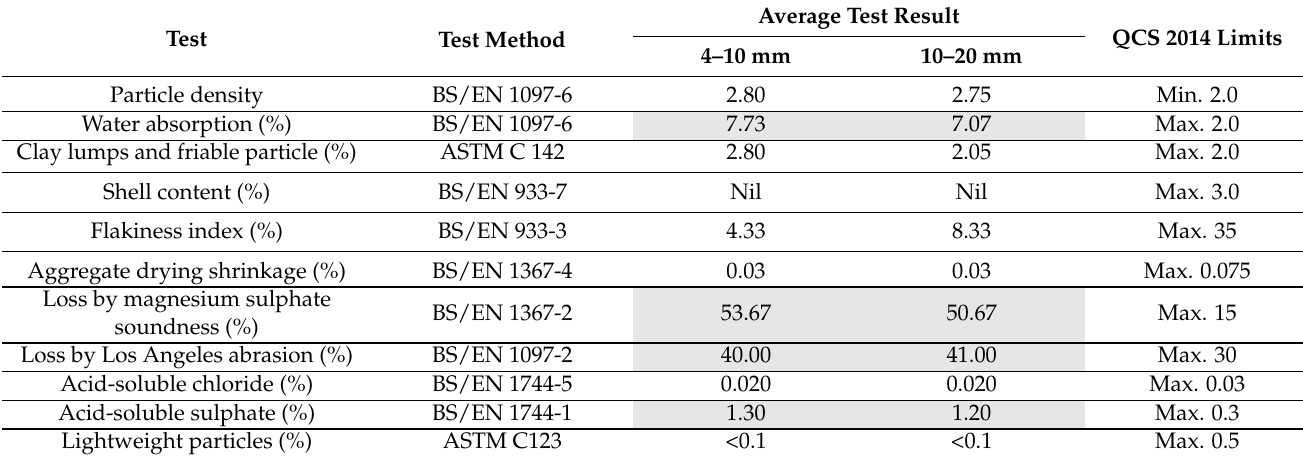
Table 3. Comparison between the properties of TBM muck and QCS 2014 (specifications of concrete coarse